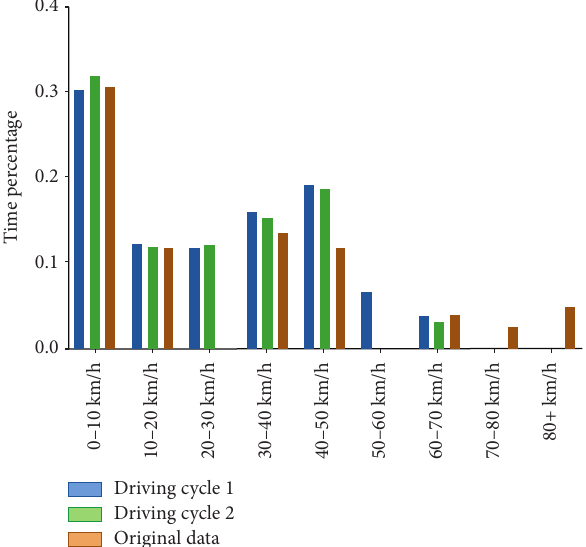
Figure 14: Speed distribution under the two driving